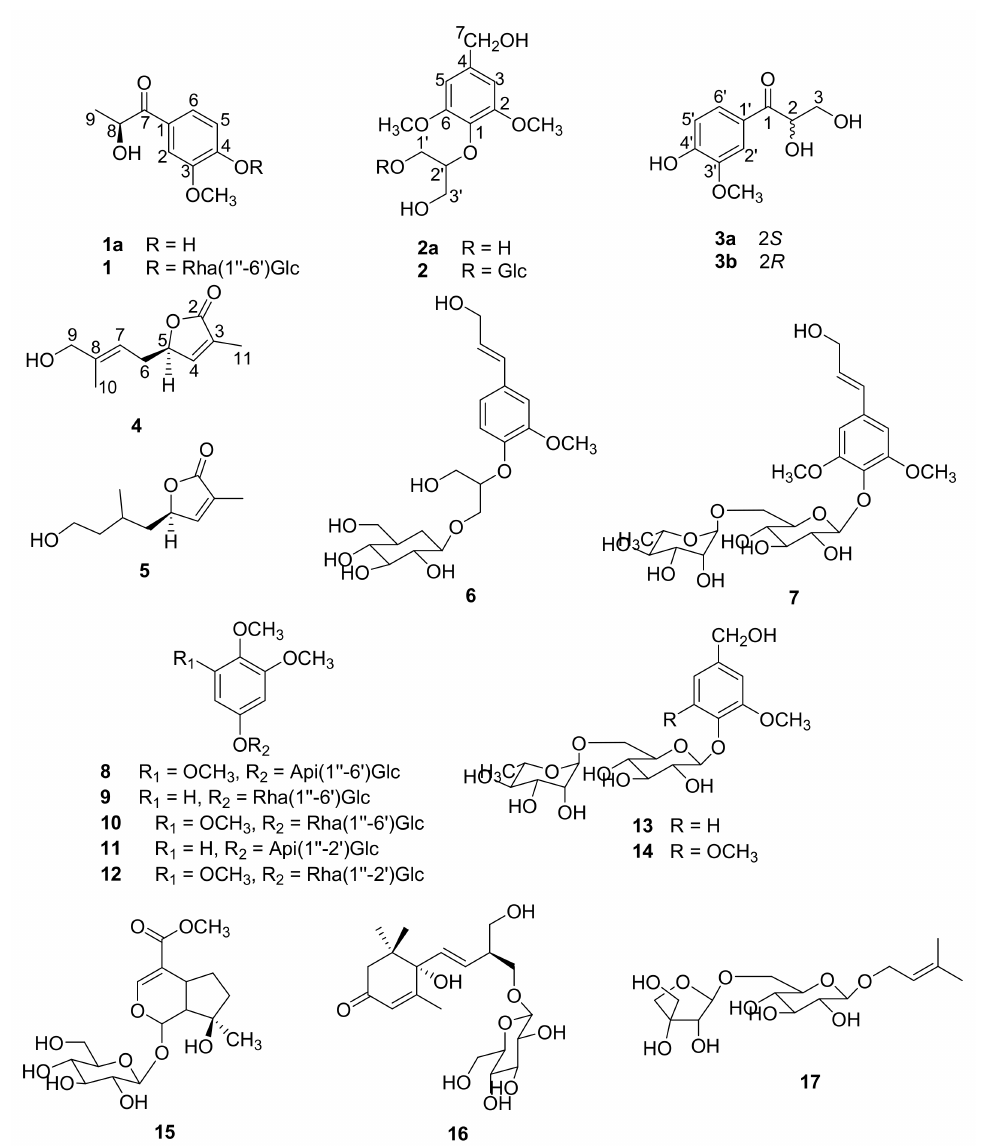
Figure 1. Structures of compounds 1 – 17